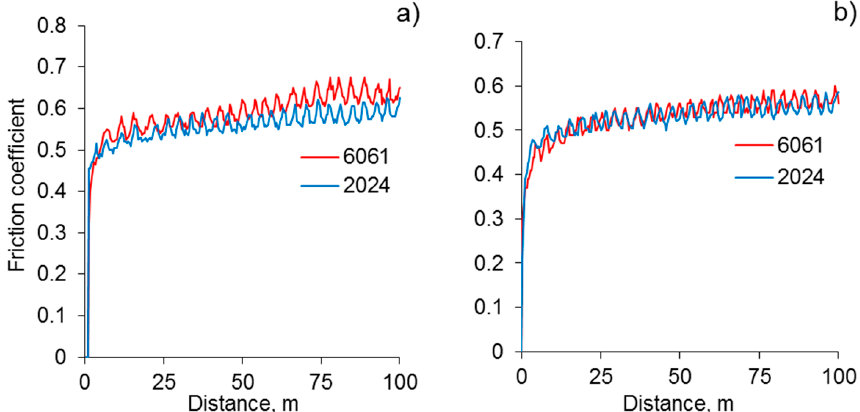
Figure 5. Evolution of the friction coefficient during the linear reciprocating wear test (LRWT) under a normal load of 5 N on the coatings with an initial thickness of 180 µm on the 2024 and 6061 alloys. The counterface materials were ( a ) bearing steel and ( b ) WC-4%Co.